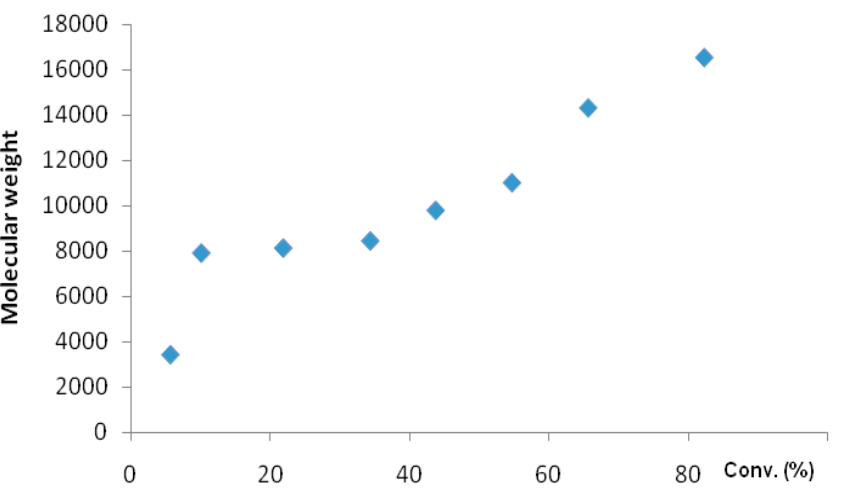
/[CTA] /[AIBN] = 400:2:1 0 0 0